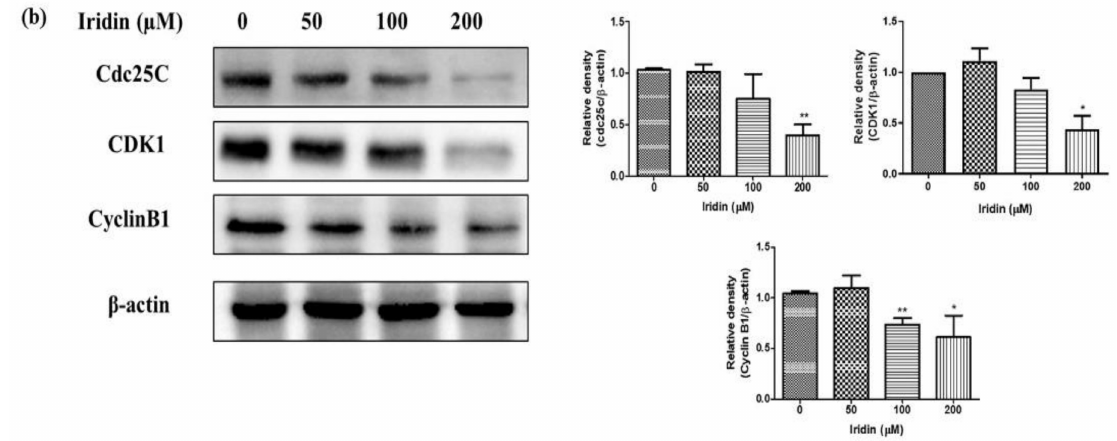
Figure 2. Iridin induces G2/M cell cycle arrest of AGS cells. ( a ) Flow cytometry was applied to evaluate the cell cycle distribution. The cells were treated with the indicated concentration of iridin (0, 50, 100, and 200 µ M) for 48 h and treated with propidium iodide (PI) stain. ( b ) Effect of iridin on cell cycle-related proteins (Cdc25C, CDK1, Cyclin B1) were measured by immunoblot. Cells were treated with iridin (0, 50, 100, and 200 µ M) for 48 h. Cell lysate were subjected to sodium dodecyl sulfate (SDS)-polyacrylamide gels and analyzed by western blot. The proteins were visualized using the detection system of Electrochemiluminescence (ECL). Bar and error bar values represent the mean ± standard error of the mean (SEM) of three separate experiments. * p < 0.05 vs. control, ** p < 0.01 vs.